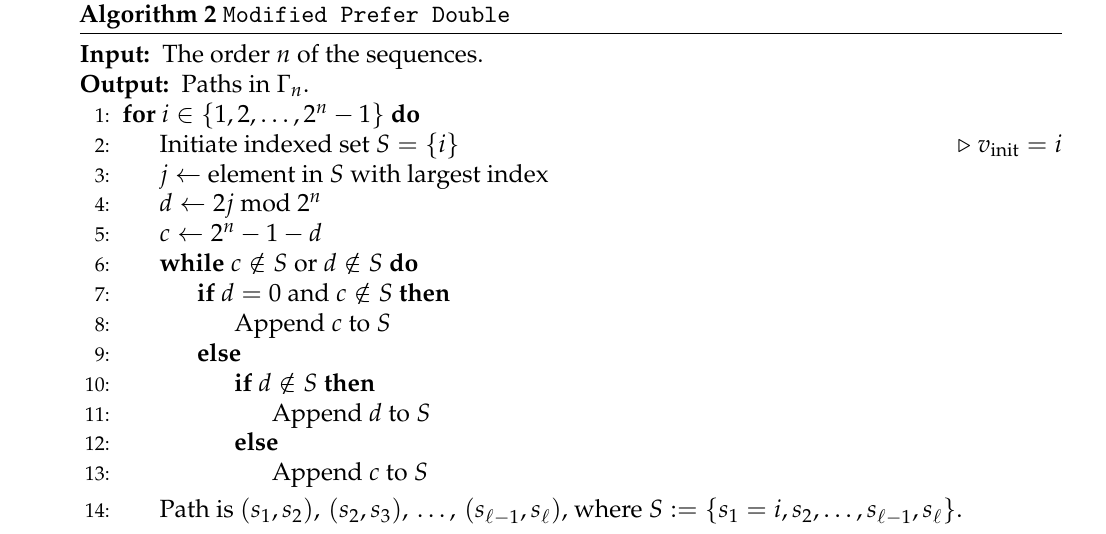
Table 3. Hamiltonian cycles constructed by Algorithms 1 and 2 for n ∈ { 4,5,6 } .